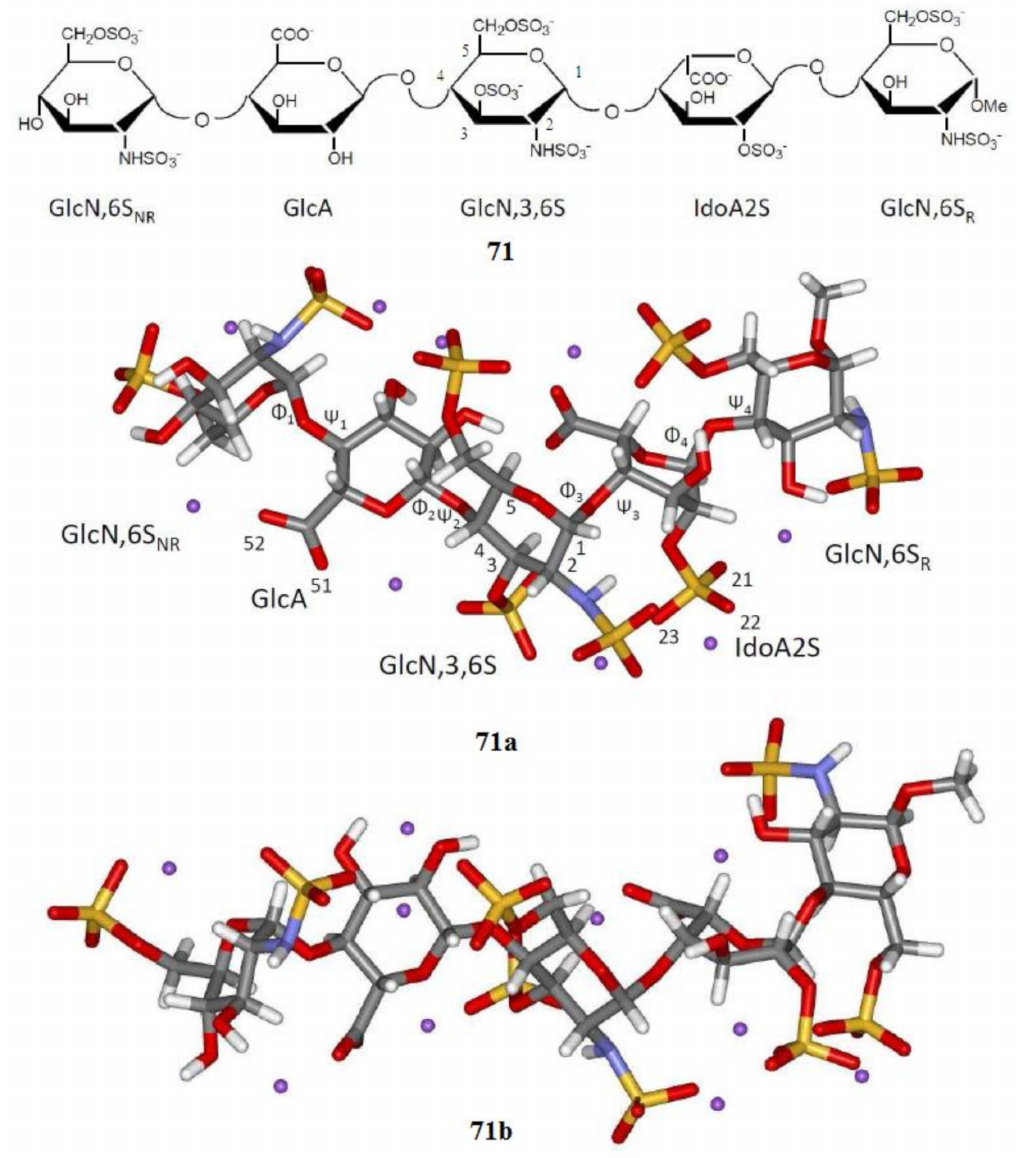
Figure 36. Chemical structure of heparin pentasaccharide ( 71 ). The IdoA2S residue is in the 1 C 4 conformation in 71a and in the 2 S 0 conformation in 71b . Other residues are in the 4 C 1 conformation. Violet dots represent sodium ions. Solvent water molecules are not shown for clarity. Reproduced from Hricovini [148] with the permission of the American Chemical